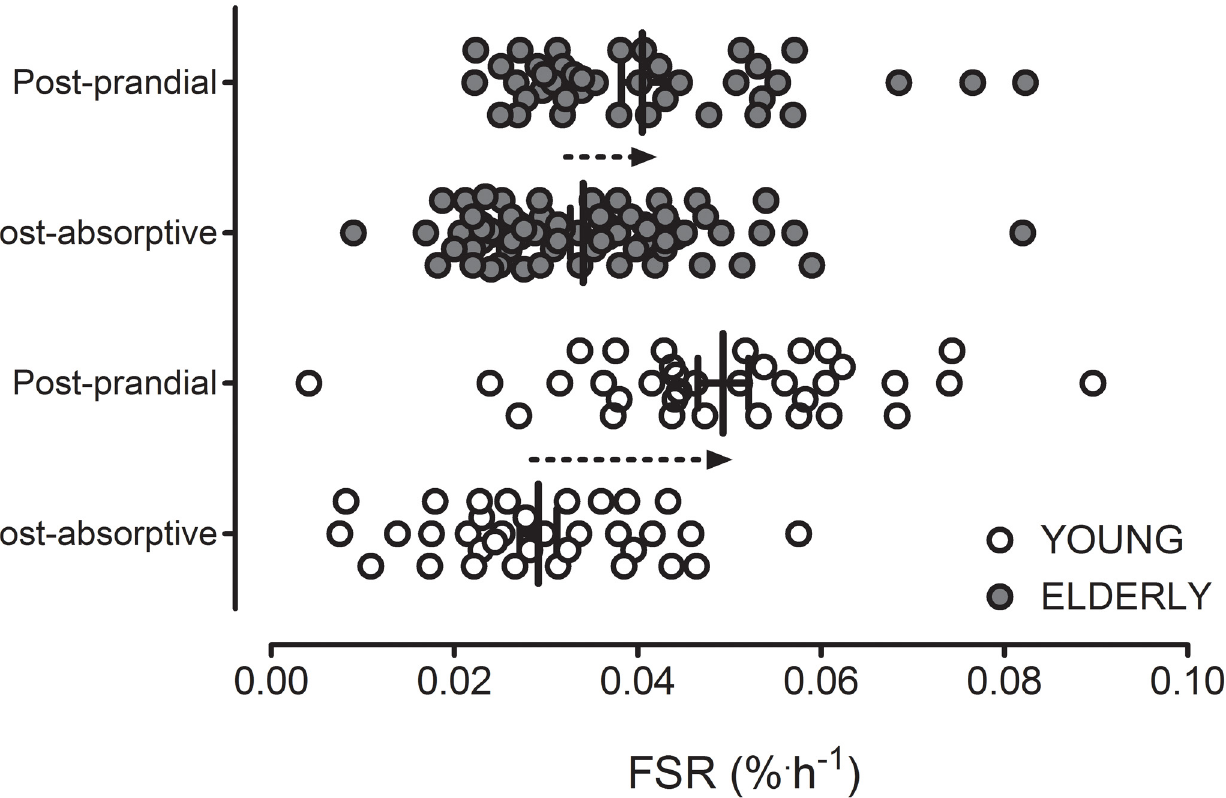
Fig 3. Graphical representation of the individual values for fractional mixed muscle protein synthesis rates (FSR), calculated using plasma L- [ ring - 2 H 5 ]phenylalanine enrichments as the precursor pool, in healthy young and elderly men in the post-absorptive state ( n = 34 young and n = 72 elderly) and following the ingestion of 20 g protein (post-prandial; n = 35 young and n = 40 elderly).